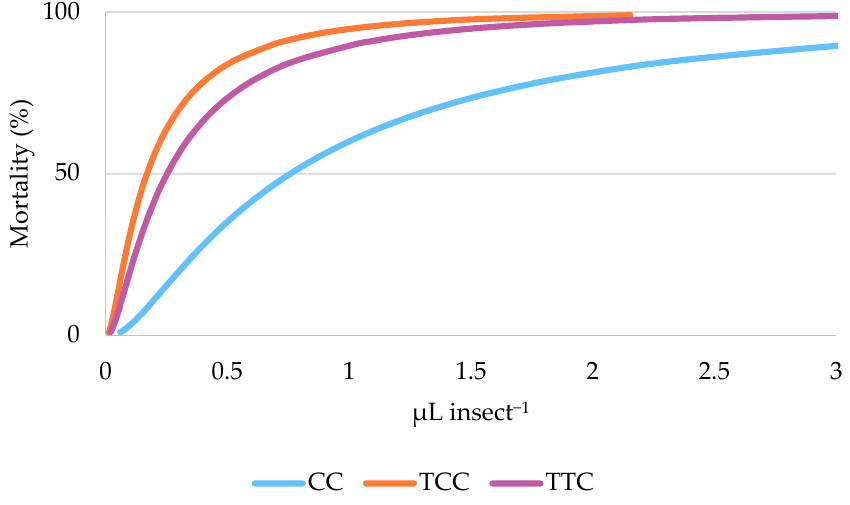
Figure 4. Dose–effect relationship of the mortality (mortality %) of Calliphora vomitoria eggs exposed by contact to carvacrol (CC), thymol/ p -cymene (TCC), and thymol/ γ -terpinene (TTC) oregano chemotypes essential oils as predicted by the Probit model.